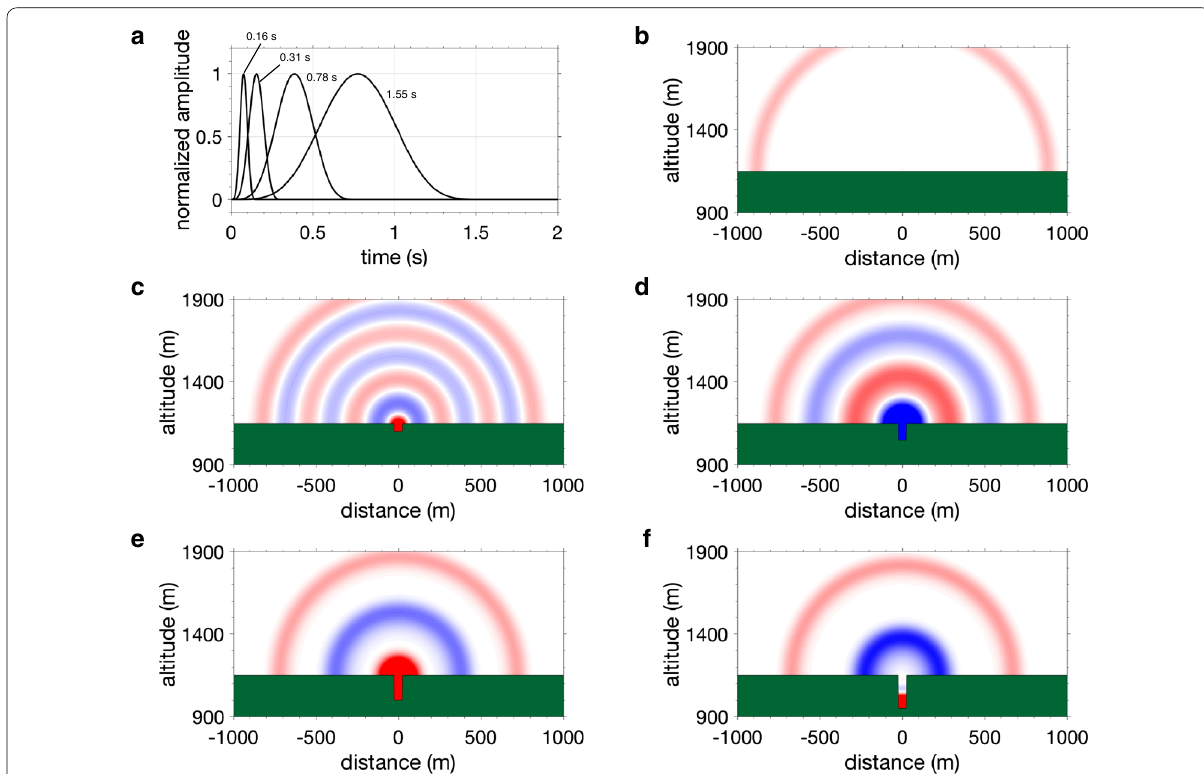
Fig. 8 Snapshots of the pressure distribution with different conduit lengths. a Simple source time functions used in our FDTD calculations. b – f Snapshots of pressure distribution at 3.0 s after the initiation of the 0.78-s width pulse. The conduit lengths are 0 m, 50 m, 100 m, 150 m, and 200 m in b – f respectively. Red and blue colors represent positive and negative pressures,